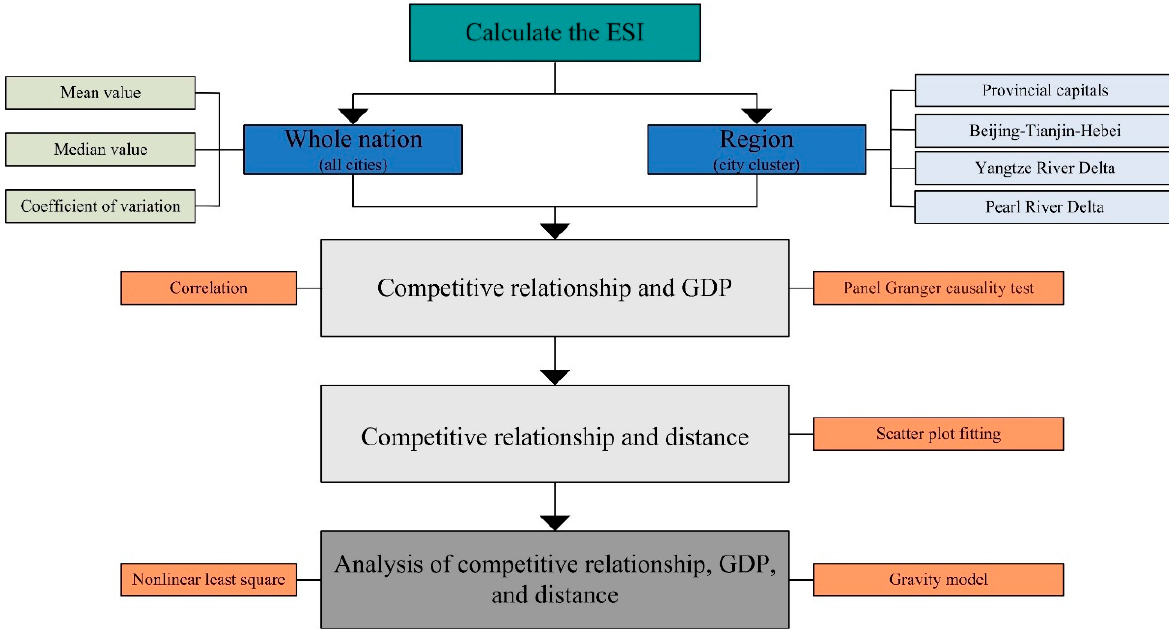
Figure 1. The research framework.